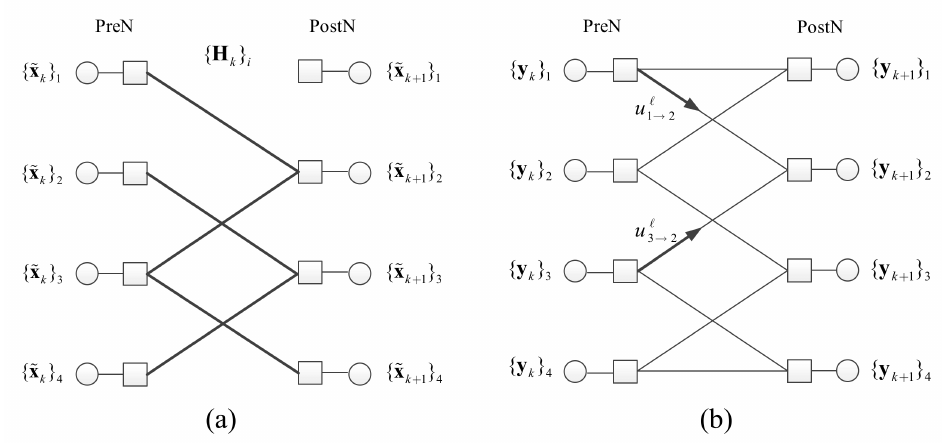
Figure 5. ( a ) Example of multiple-access tone transition graph; ( b ) Example of base graph corresponding to an example